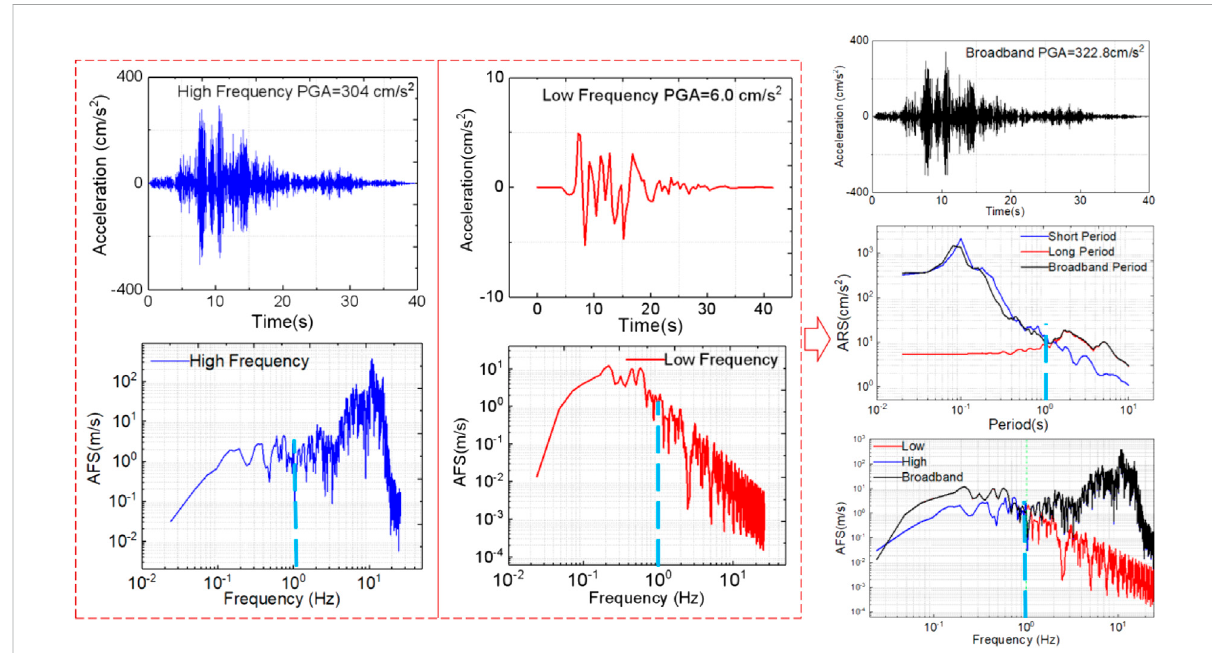
FIGURE 3 Schematic diagram of superposition of high-frequency and long-period ground motion waveforms in the frequency domain.